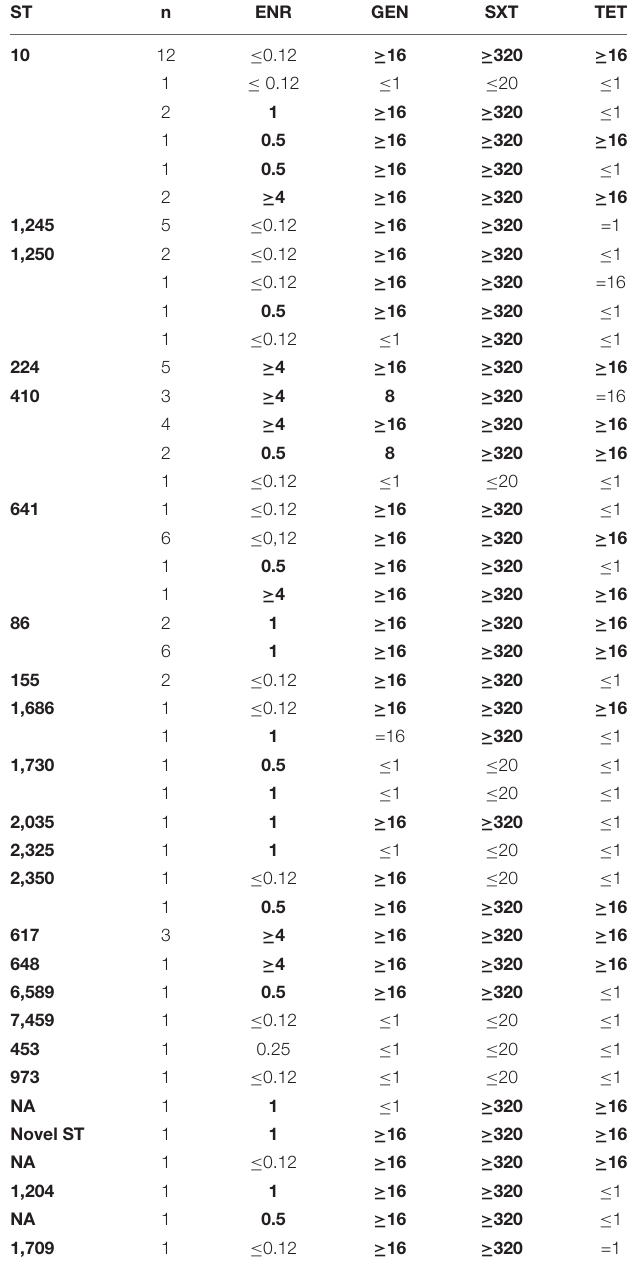
TABLE 1 | AST profiles of ESBL-EC isolated from specimens of hospitalized